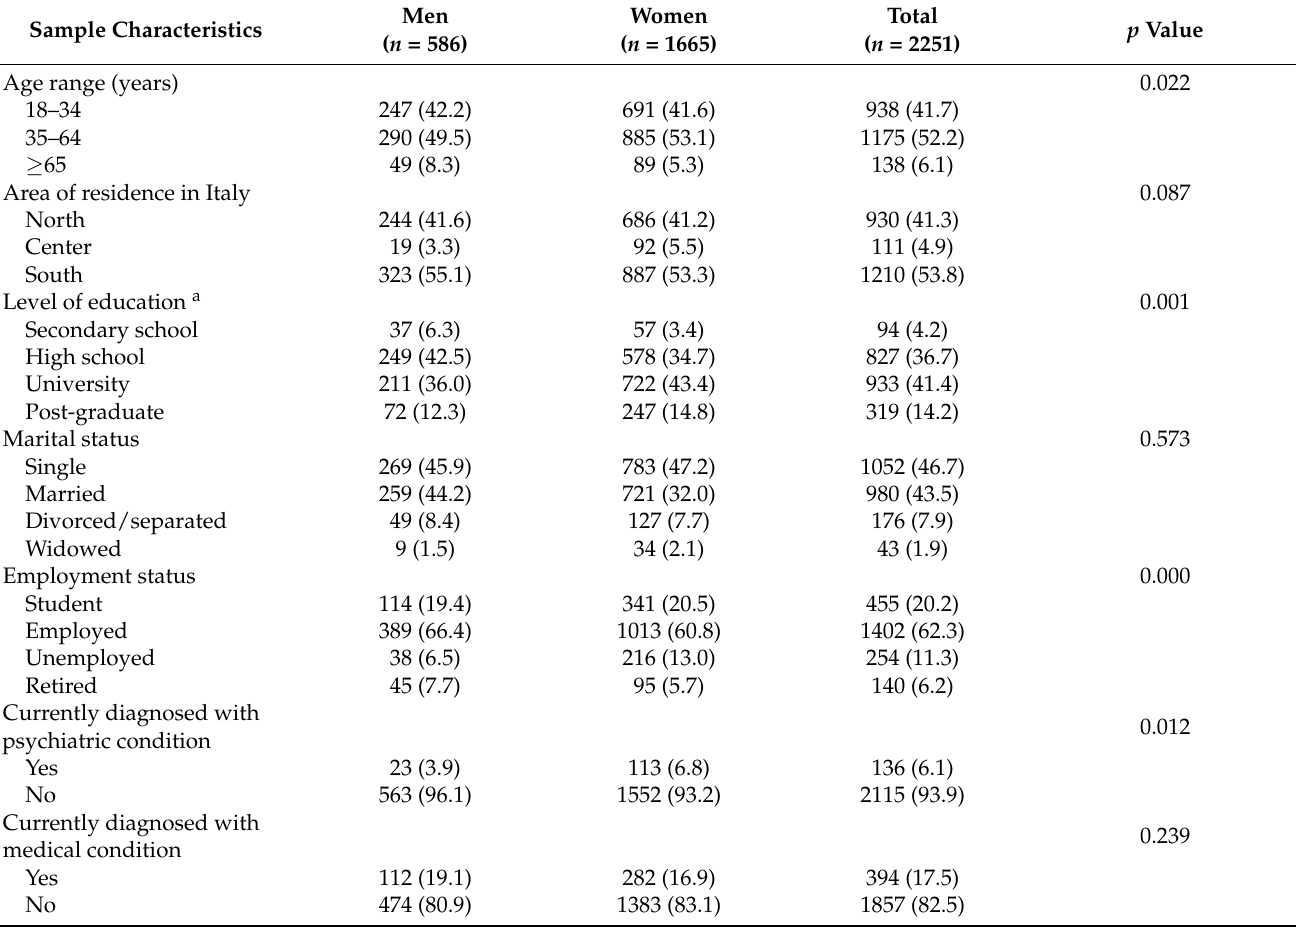
Table 1. Frequencies (%) of the main demographic characteristics for men, women, and global sample. Sample